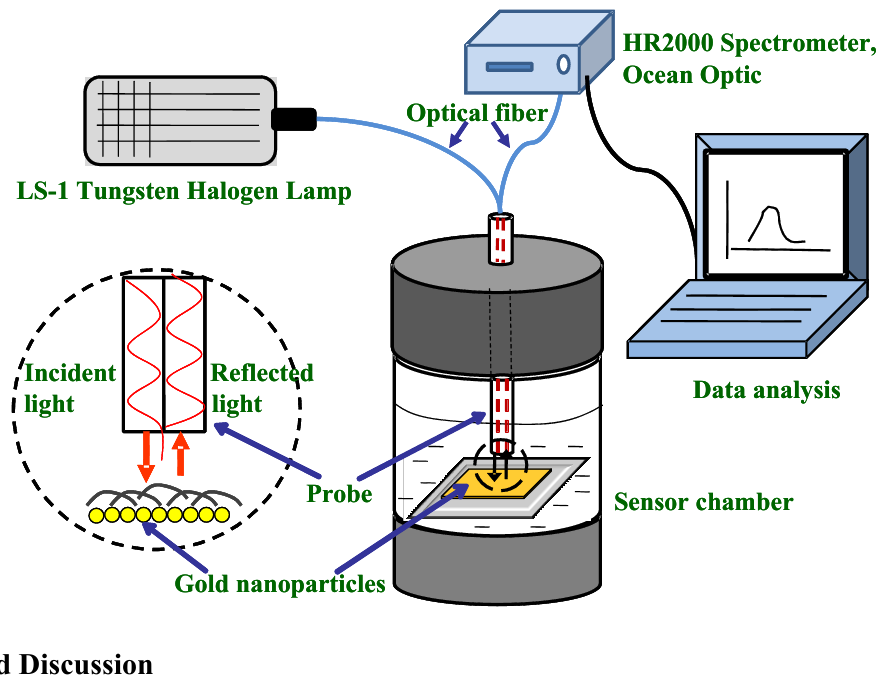
Figure 1. Sensing system set up utilizing fiber optic and gold